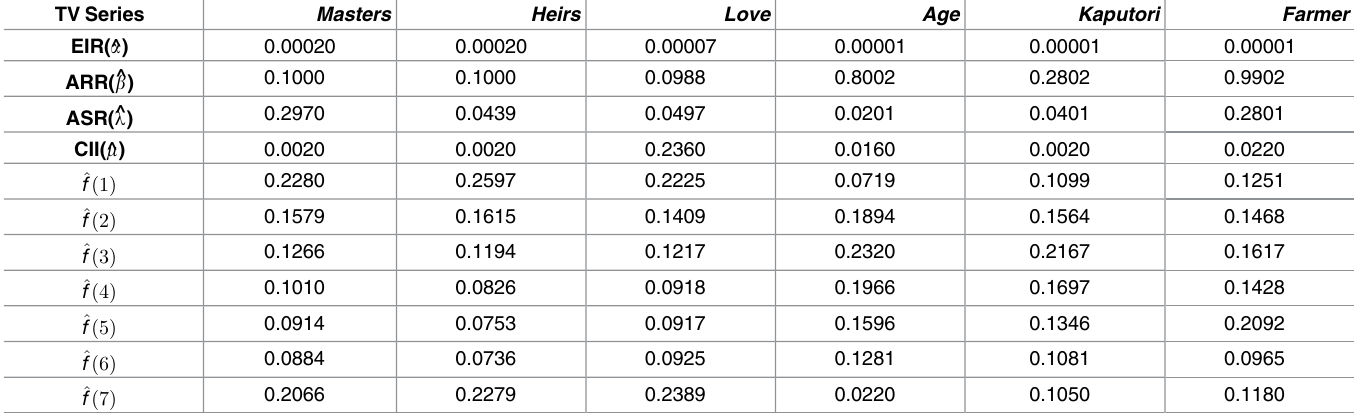
Table 2. Estimated parameters of the six